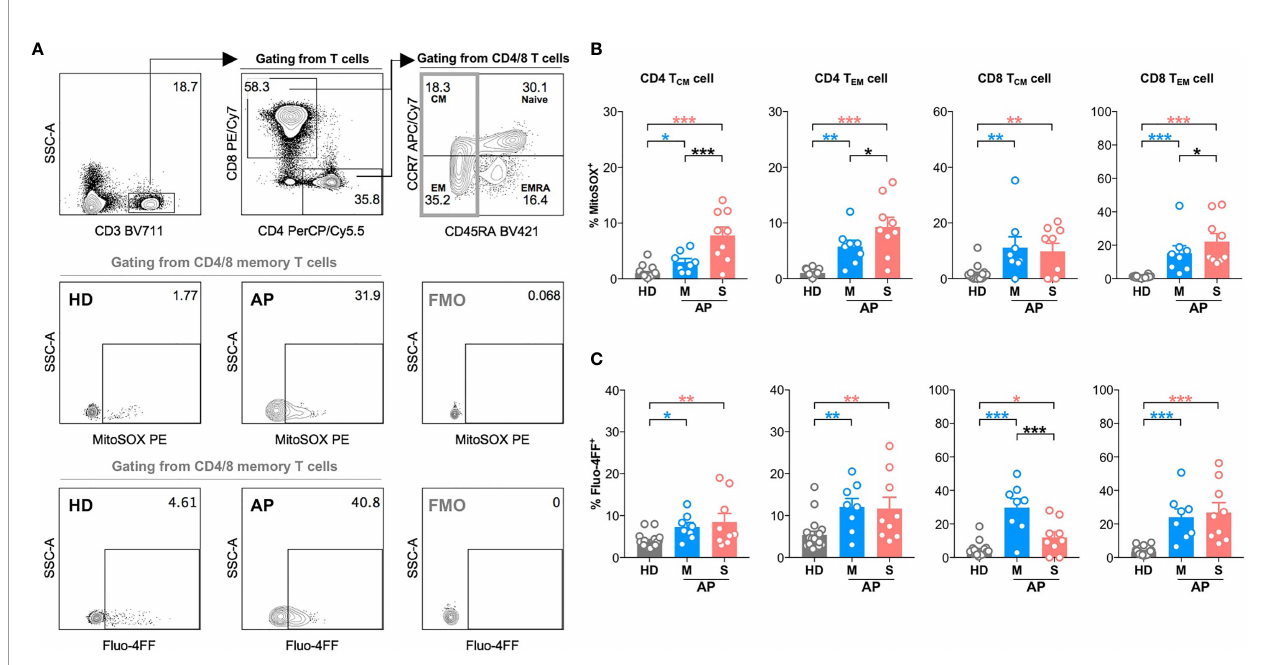
FIGURE 3 | High mitochondrial reactive oxygen species (ROS) level and intracellular calcium level are found in memory CD4 or CD8 T cells at 11-15 days p.s.o. during SARS-CoV-2 infection. Seventeen SARS-CoV-2 acute patients [APs; 8 mild (M) and 9 severe (S) ones on Day 11 – 15 post symptom onset (p.s.o.)] and 18 healthy donors (HDs) were collected for FACS analysis in at least three independent experiments. (A) Representative plots showed the gating strategy on MitoSOX + cells and Fluo-4FF + cells among memory CD4 or CD8 T cells. The percentages of MitoSOX + cells (B) and Fluo-4FF + cells (C) in CD4 T CM , CD4 T EM , CD8 T CM , and CD8 T EM cells from mild and severe APs on Day 11 – 15 p.s.o. were displayed in bar charts. HDs served as control. Data represent mean ± SEM. Statistics were calculated based on one-way ANOVA test. * p < 0.05, ** p < 0.01, *** p <